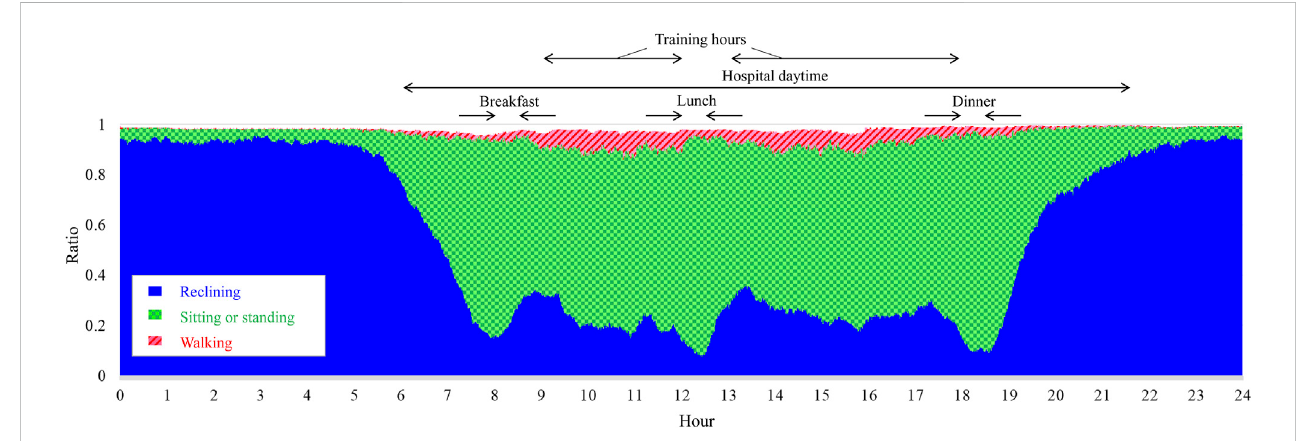
FIGURE 5 Postures of stroke patients during 24 h. The vertical axis shows the population ratio, where 1 represents the total number of participants, n = 306.